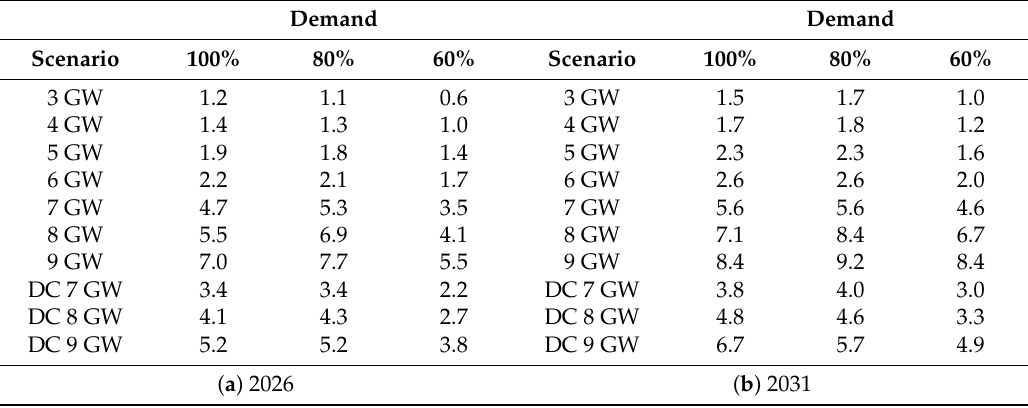
Table 8. Reactive power compensation for stabilizing the power